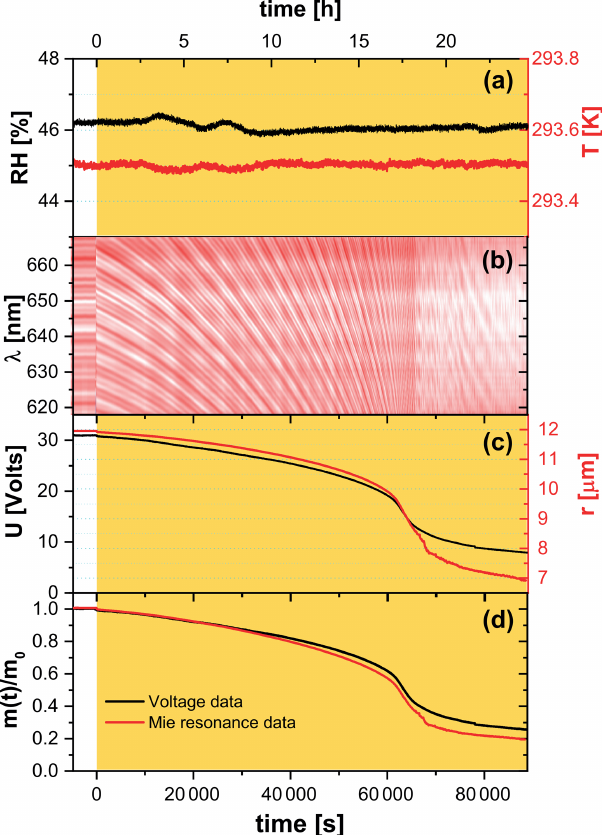
Figure 2. Raw EDB experimental data for a Fe III ( Cit ) /CA (molar ratio of 0.05) particle. (a) Relative humidity (left axis, black) and temperature (right axis, red) of the droplet. (b) Intensity map of low-resolution Mie-resonance spectra. (c) Black line: DC voltage that compensates gravitational force; red line: radius of the droplet, with the initial value of the particle radius determined using high- resolution Mie-resonance spectroscopy (not shown), and the change in radius determined from low-resolution Mie-resonance data given in (b) . (d) Normalized mass remaining ratio deduced from DC volt- age (black), and from Mie-resonance shift (red) – assuming constant density. Yellow shaded region in panels (a) , (c) , and (d) indicate the time of laser irradiation with 0.25Wcm − 2 at